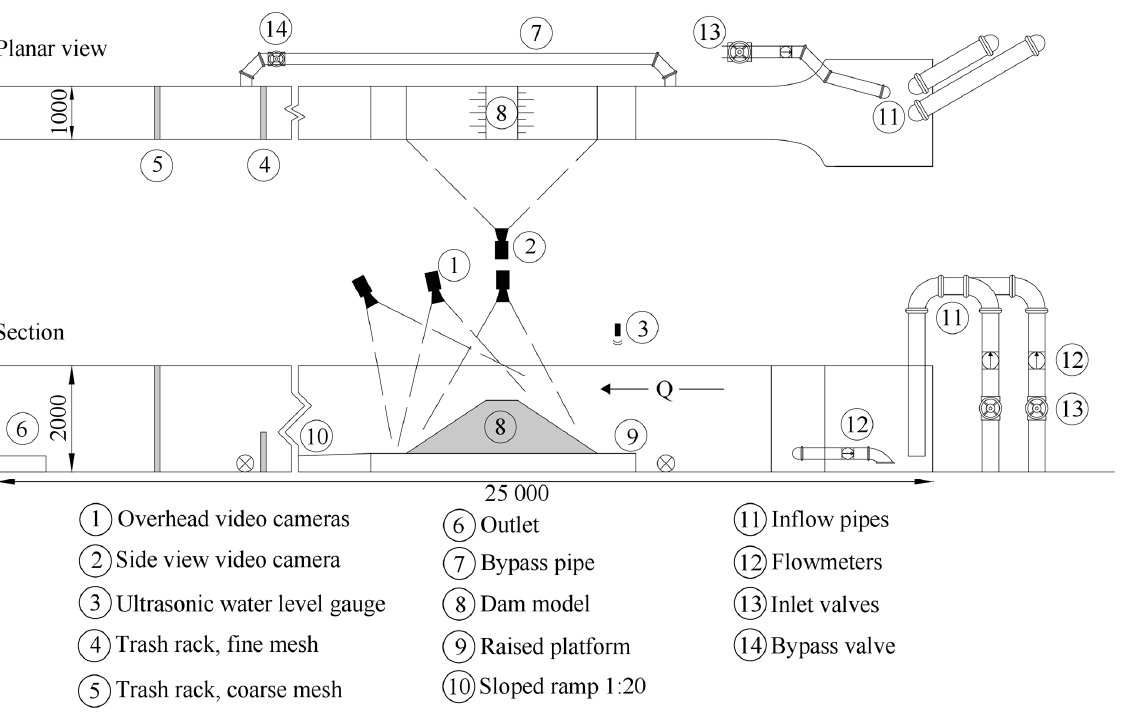
Figure 1. Hydraulic flume at NTNU (units in mm) flow from right to left. Table 1. Overview of model tests with key